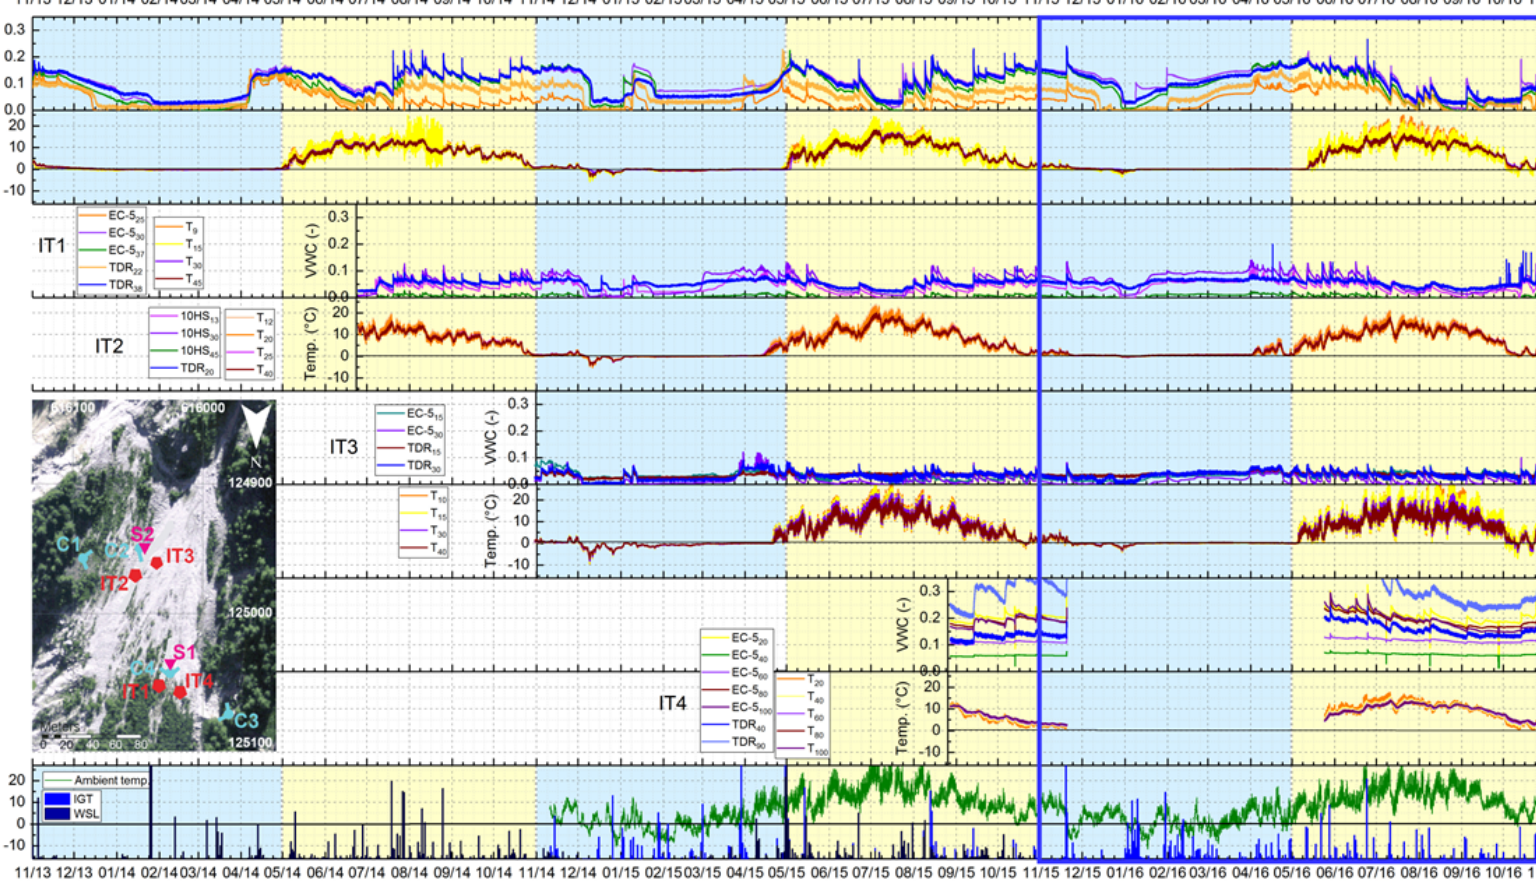
Figure 11. Volumetric Water Content (VWC) & Temperature IT1-4. Overview of measurements at instrumented trenches IT1-4 in the Meretschibach catchment for three years duration of seasonal field monitoring (November 2013–October 2016): VWC, temperature with precipitation data at the bottom.